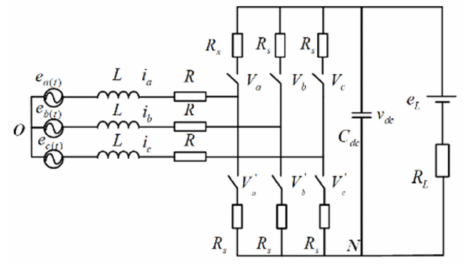
Figure 6. Topology of PWM rectifier.